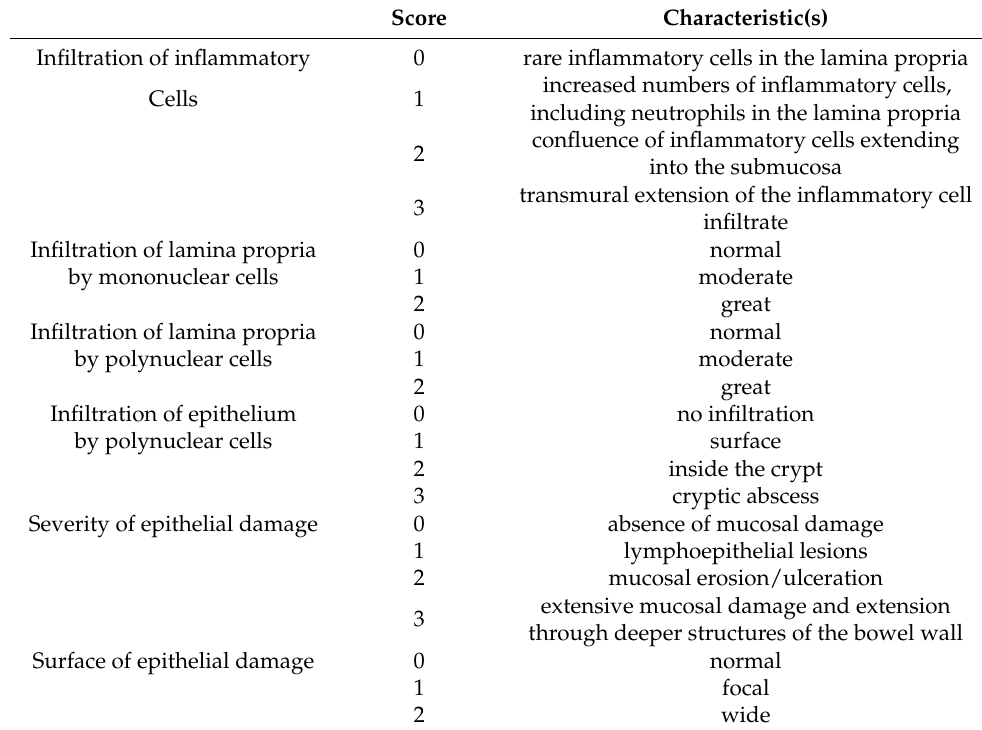
Table 3. Histological grading of intestinal